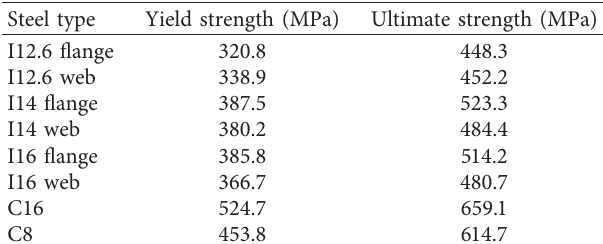
Figure 1: Specimen size and section reinforcement. Table 2: Steel strength